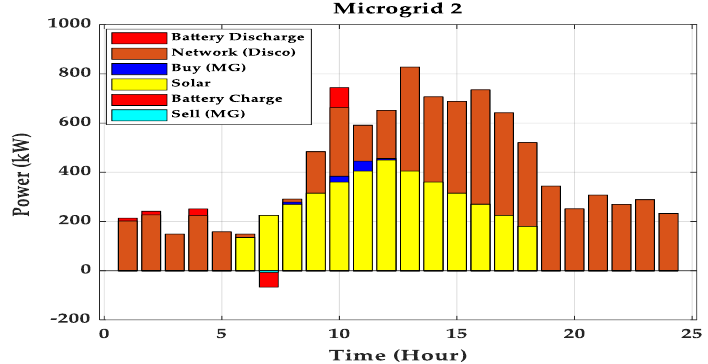
Figure 9. Microgrid 2 ’s load curve.